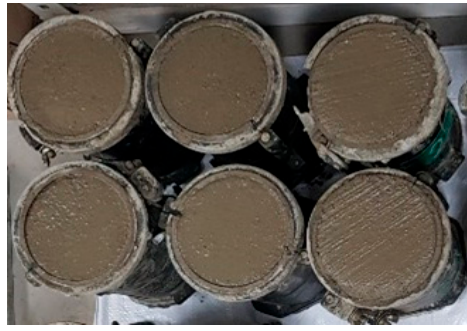
Figure 3. Specimen for chloride ion migration coefficient .